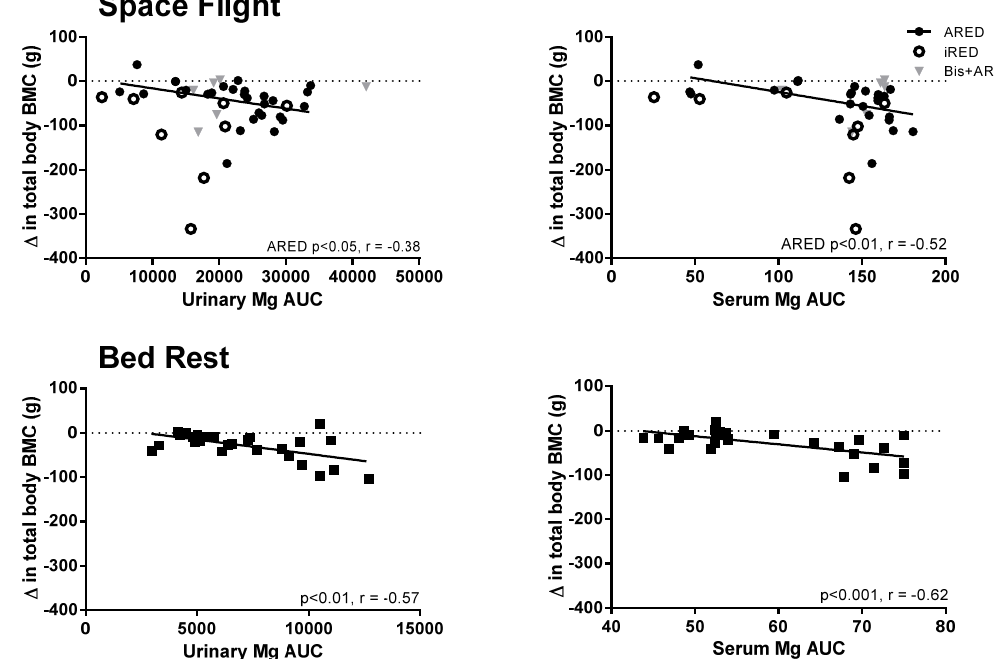
Figure 3. The response of urinary ( n = 42) and serum ( n = 38) magnesium during flight, expressed as the area under the curve (AUC), is related to the change in total body bone mineral content (BMC) after flight on the International Space Station (upper panels), and the AUC of urinary and serum Mg after 28 to 90 days of bed rest ( n = 27 urine and serum) is related to the change in total body BMC after 60 to 90 days of bed rest (lower panels). Each circle represents an individual crewmember. In the upper panels, filled circles represent crewmembers who had access to the Advanced Resistive Exercise Device (ARED) and open circles represent crewmembers who had access to the interim resistive exercise device (iRED). Crewmembers treated with the bisphosphonate alendronate are shown with gray triangles. Pearson correlation coefficients are presented for significant correlations.